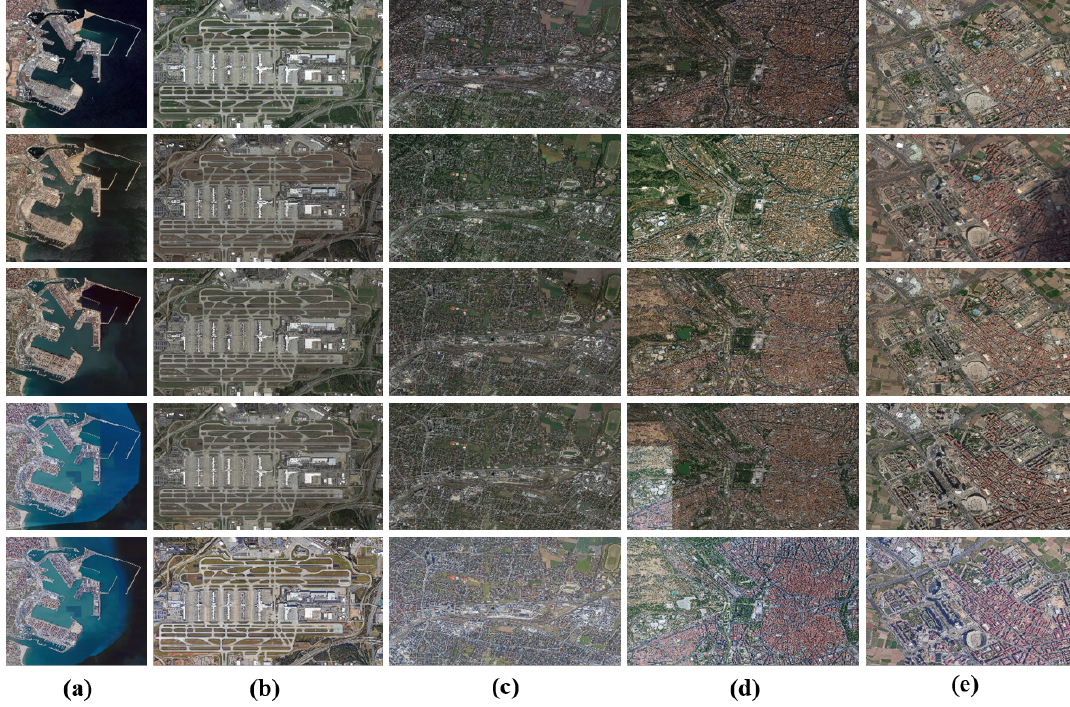
Figure 7. Image examples from historical Google images. ( a ) Seaport (Valencia); ( b ) Airport (Atlanta); ( c ) Railway Station (Munich); ( d ) Park (Madrid); ( e ) Urban Center